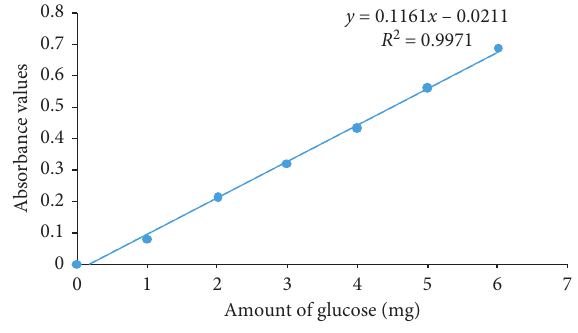
Figure 1: Glucose standard Table 1: Effect of fermentation on yield of sorghum-resistant starch. Unfermented sorghum- Fermented sorghum- Sample resistant starch resistant starch Yield (%) 35.28 ± 1.25 a